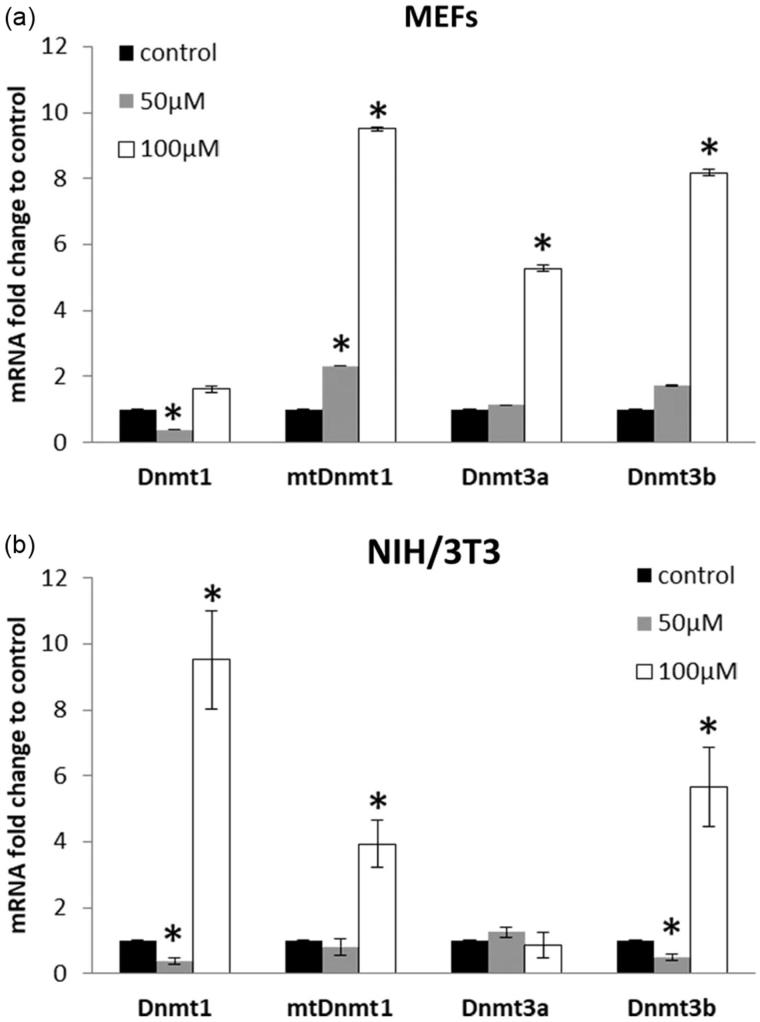
DNA methyltransferases mRNA expression in MEF (a) and NIH3T3 (b) cells incubated with oregonin in doses 50 and 100 μM for 24 h. The data are presented as a mean ± SD of three independent experiments. Fold change cut-off of ≥2 and p values ≤ 0.05 compared with the control were considered to be upregulated, while with FC ≤ 0.5 and p ≤ .05 were considered to be downregulated. *p < .05.